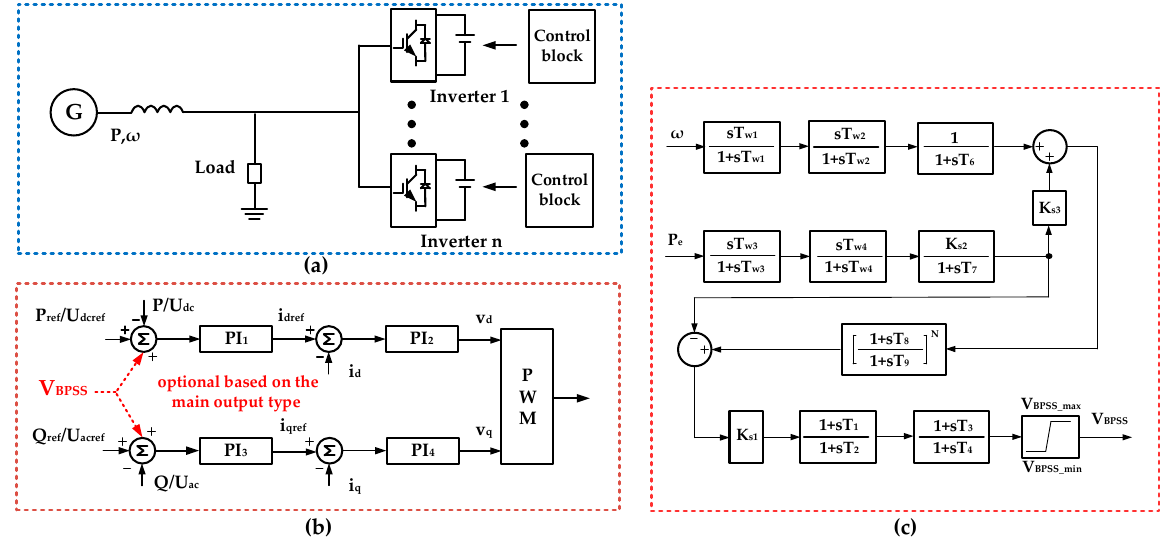
Figure 7. PSS control structure for grid-connected inverter and application in the system. ( a ) System structure; ( b ) superposition point of PSS output in the inverter control; ( c ) PSS control structure.